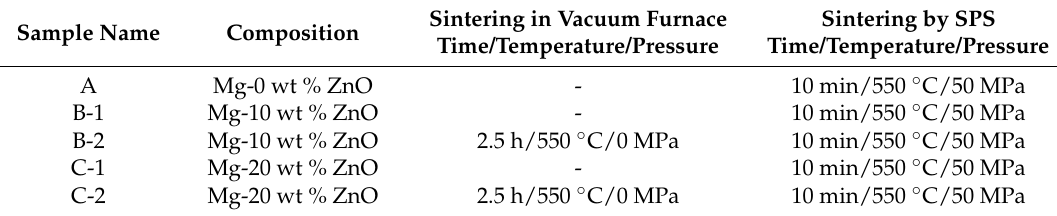
Table 1. Composition and sintering conditions of five kinds of